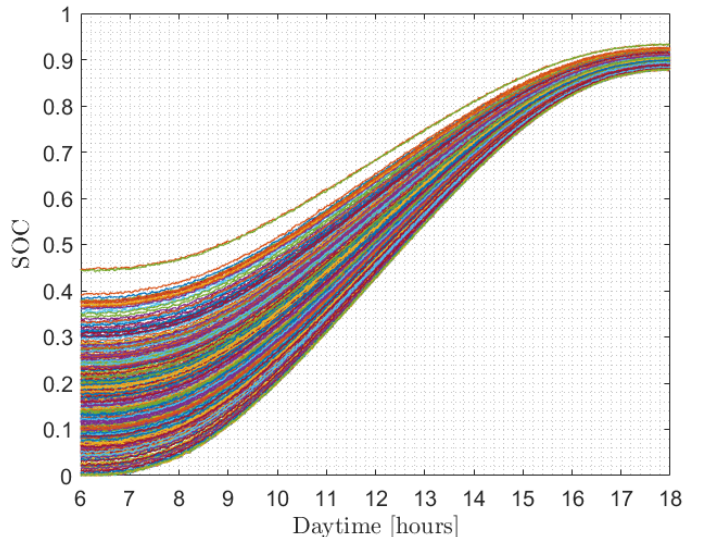
Figure 5. Empirical per BEV average SOCs ( x t ) of a fixed population of 400 BEVs.